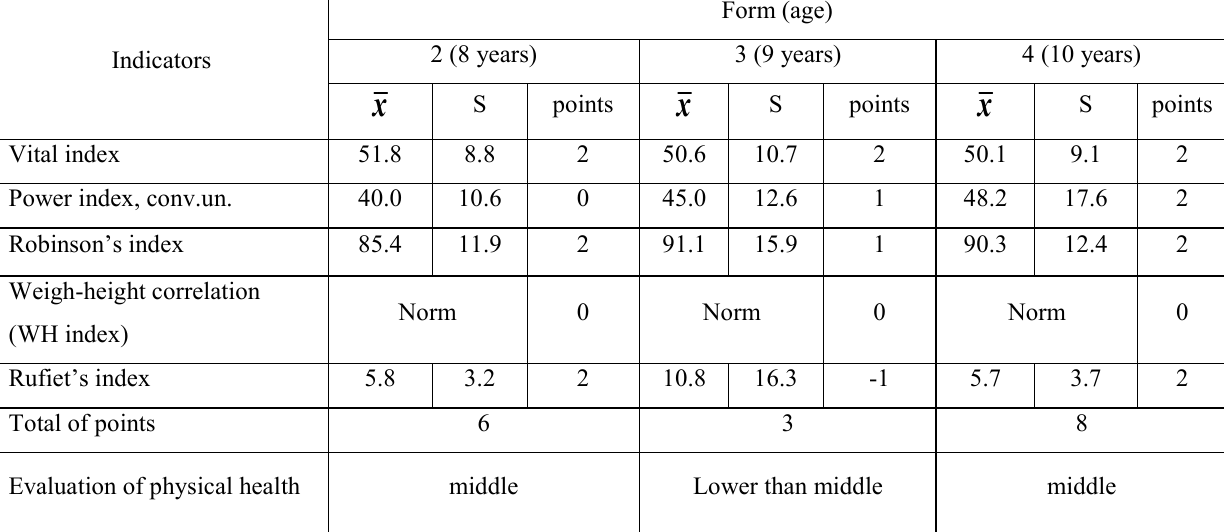
Level of physical health (according to indicators) of girls from 2 - 4